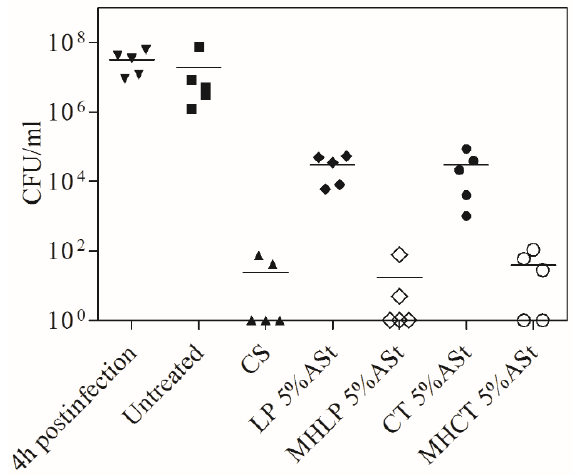
Figure 5. Effect of different formulations on antibacterial activity. Tape-stripped mice were infected with S. aureus ATCC 6538. The number of bacteria (cfu/mL) extracted from each mouse is represented by the symbol for the corresponding experimental group. The median value of the data for each group is shown as a horizontal bar. CS: Commercial solution.